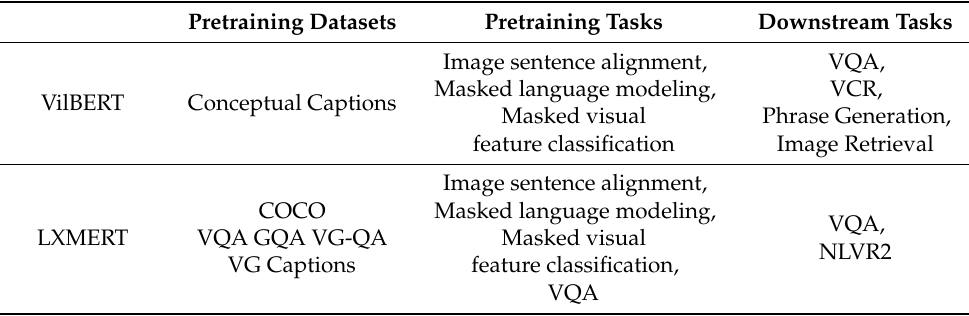
Table 7. Comparison between ViLBERT and